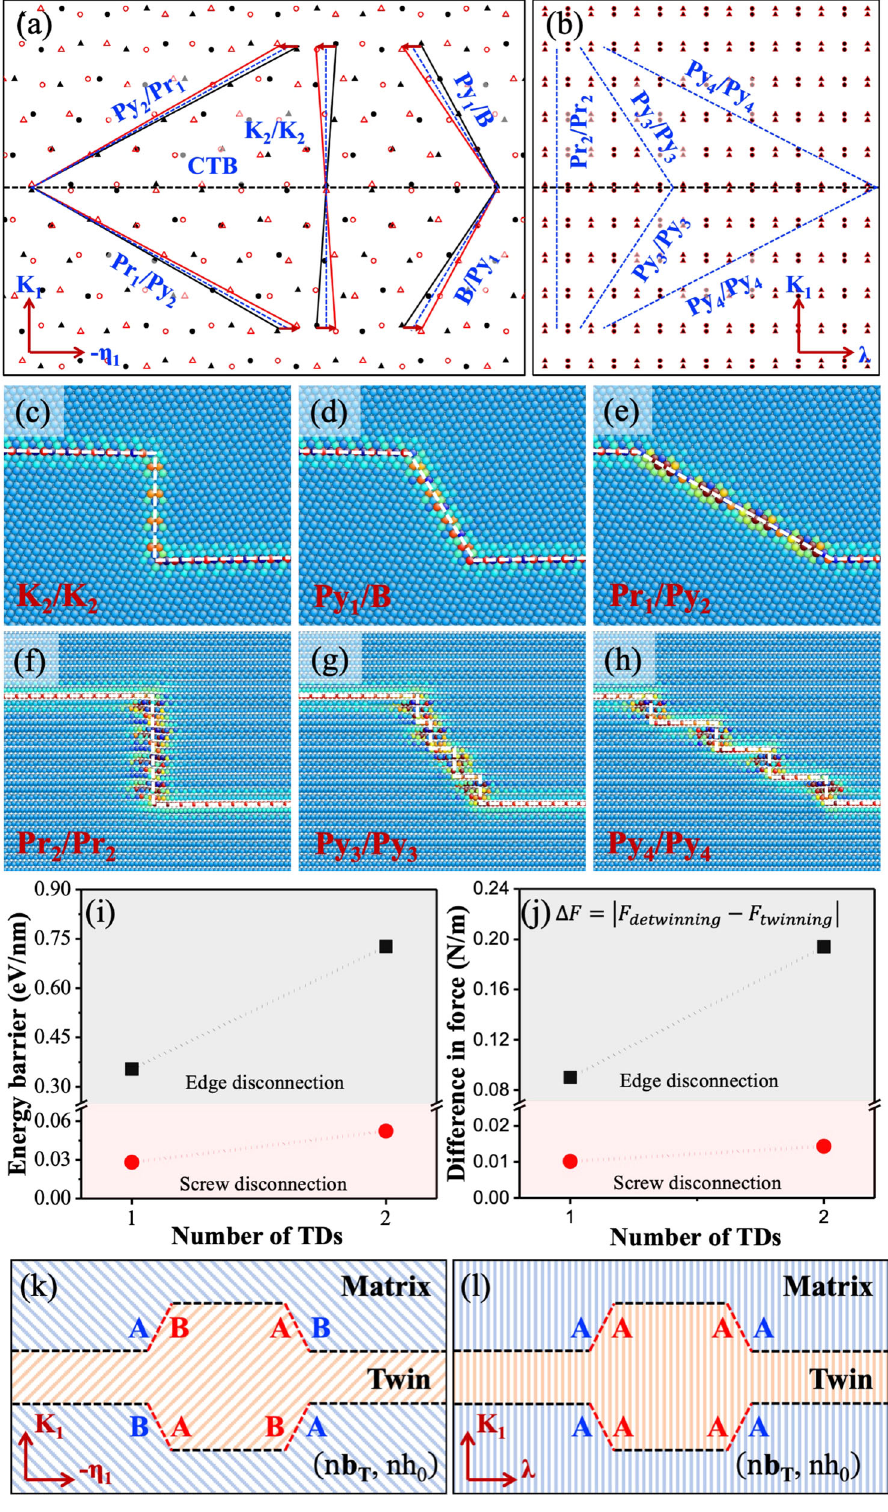
(cid:1) (cid:3) Fig. 3 Structures and kinetics of twin facets. CDC associated with 1011 twinning a viewed along λ direction predicts the B/Py 1 or Py 1 /B, Pr 1 /Py 2 or Py 2 /Pr 1 and K 2 /K 2 interfaces, and b viewed along - η 1 direction predicts the Pr 2 /Pr 2 , Py 3 /Py 3 and Py 4 /Py 4 interfaces. Relaxed structures containing c K 2 /K 2 facet, d Py 1 /B fac e t, and e Pr 1 /Py 2 facet in BS view. Relaxed structures containing f Pr 2 /Pr 2 facet, g Py 3 /Py 3 facet, and h Py 4 / Py 4 facet in DS view. i The change of potential energy associated with the migration of a Py 1 /B or a Pr 2 /Pr 2 facet with respect to the number of edge or screw TDs on the facet. j Difference in resistance force associated with the migration of a Py 1 /B or Pr 2 /Pr 2 facet along twinning and detwinning directions with respect to number of edge or screw TDs on the facet. Schematics showing terraces on CTBs consisting of k CTBs, A/B and B/A facets in BS view and l CTBs and A/A facets in DS view.